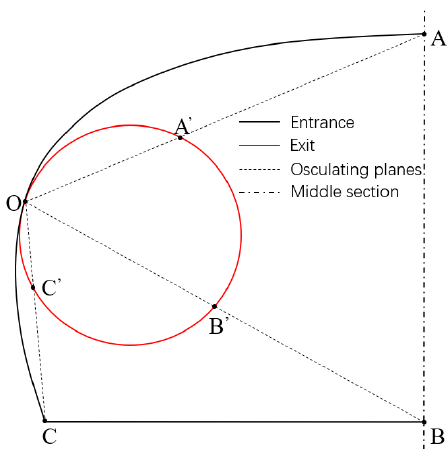
Figure 7. Osculating planes for the new spillage ‐ adaptive inlet.